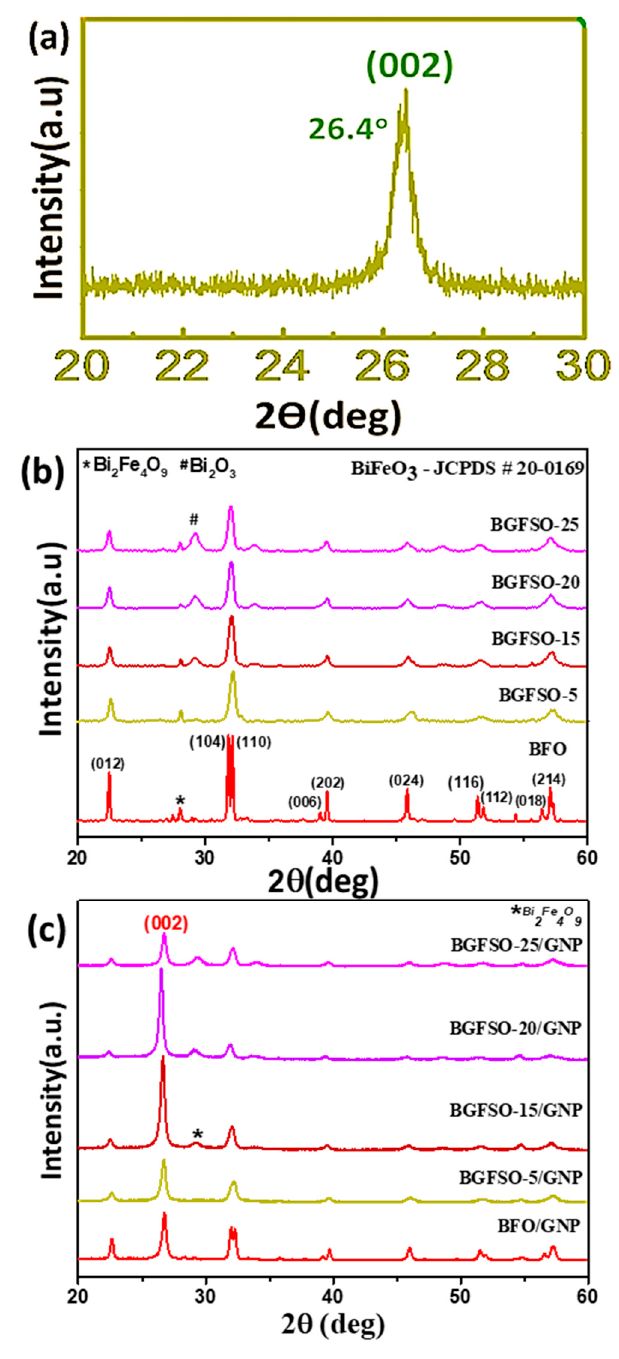
Figure 1. XRD patterns of: ( a ) GNP; ( b ) BGFSO nanoparticles; ( c ) BGFSO/GNP nanohybrids.